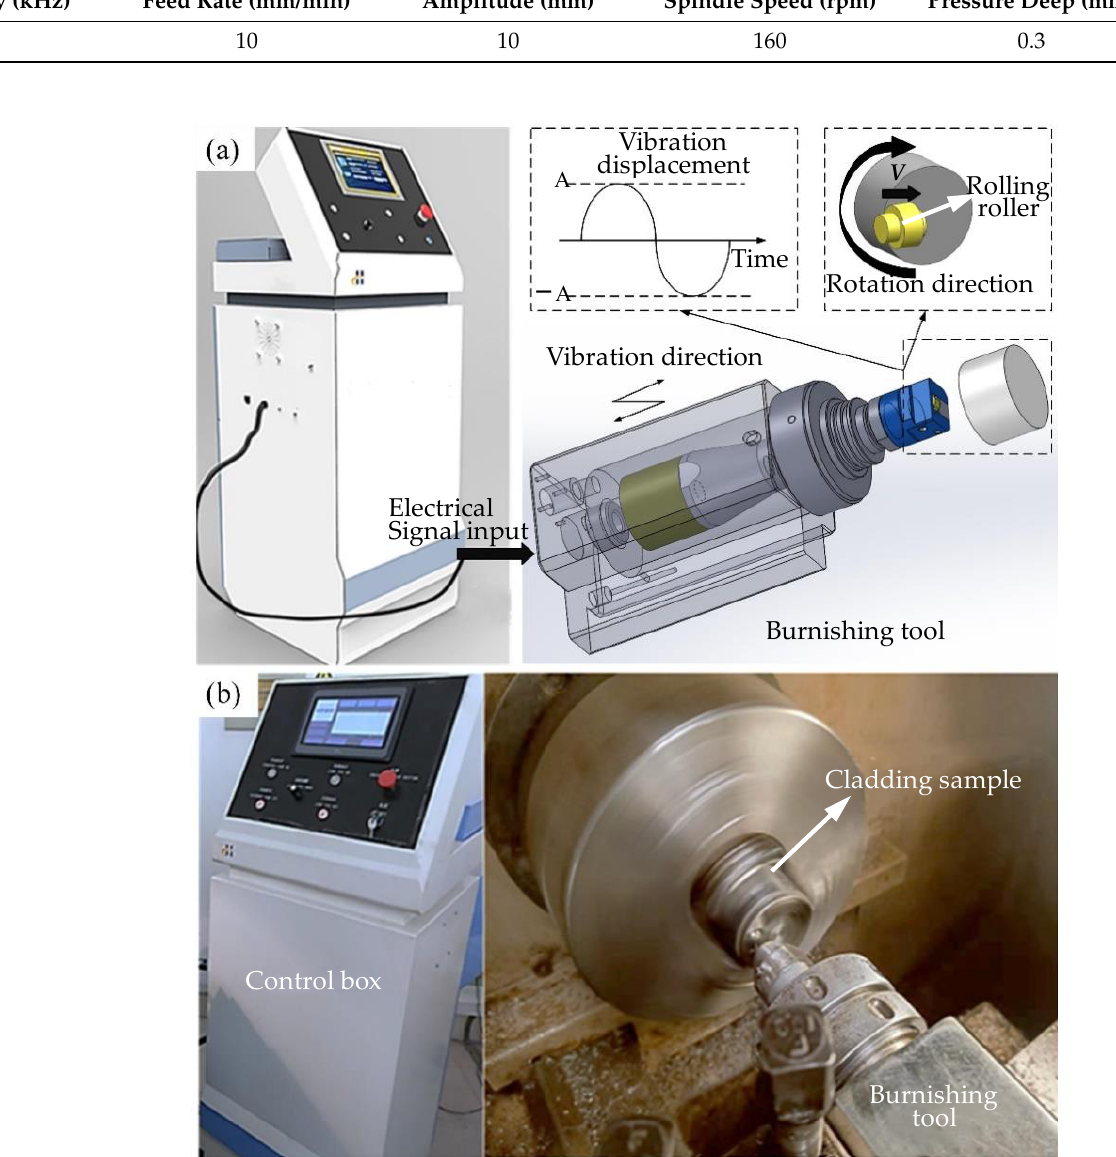
Figure 3. ( a ) Illustration of UB processing, ( b ) photos of the UB experiment